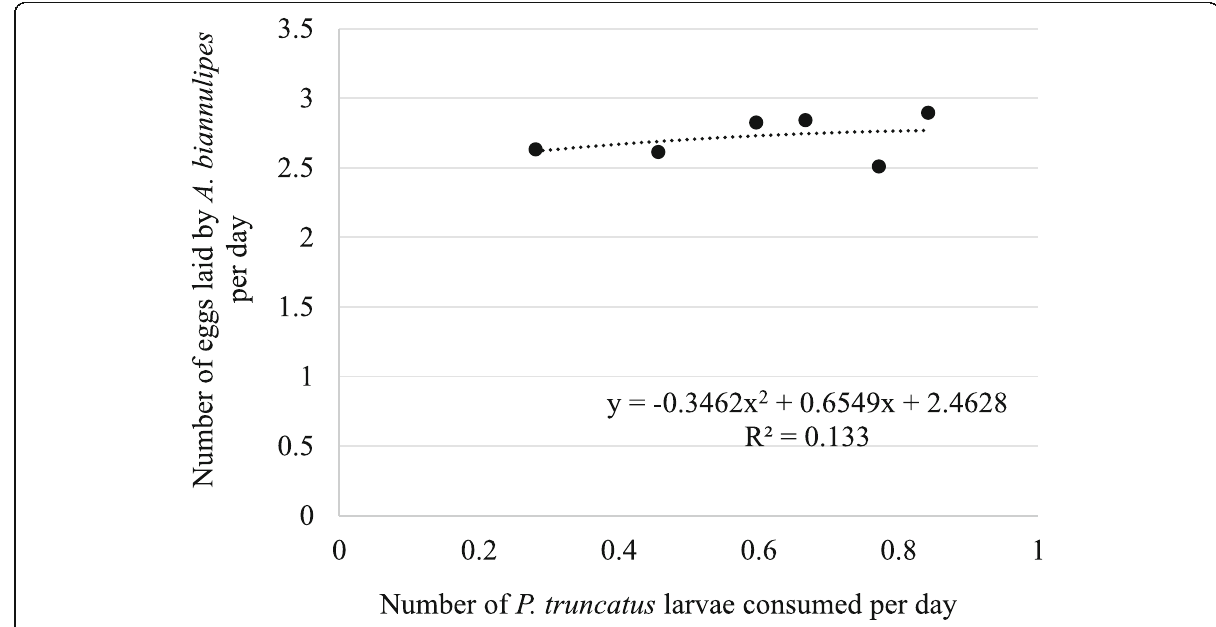
Fig. 4 Average number of eggs laid per female A. biannulipes based on P. truncatus larvae